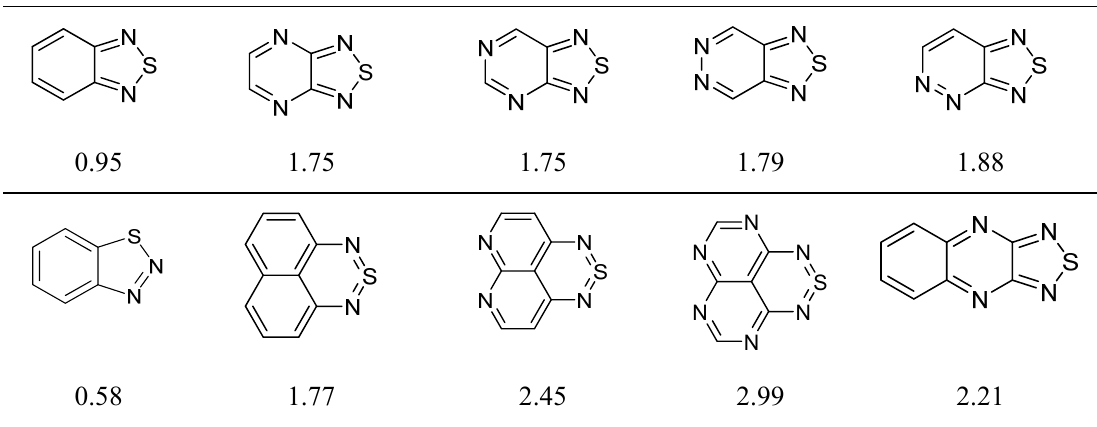
4. ( U)B3LYP/6-31+G(d) adiabatic EA (eV) of 1,2,5-thiadiazoles